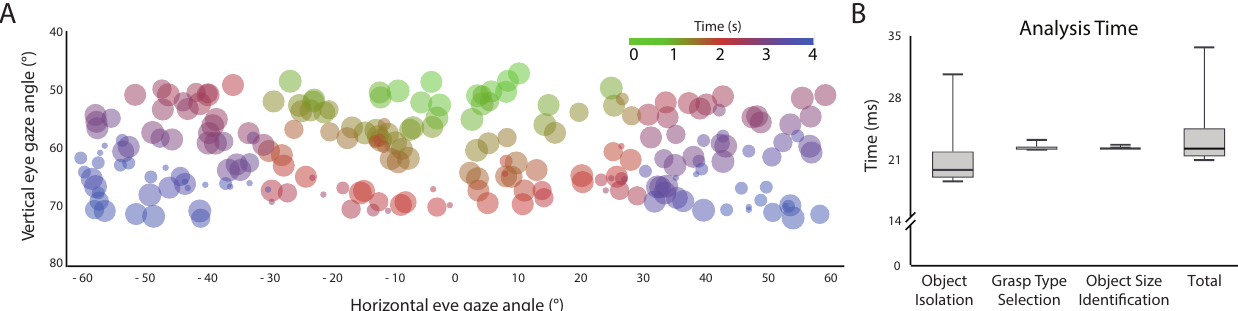
Figure 9. ( A ) Distribution of time required to localize an object and determine the width of the object; ( B ) The required time for different stages of image